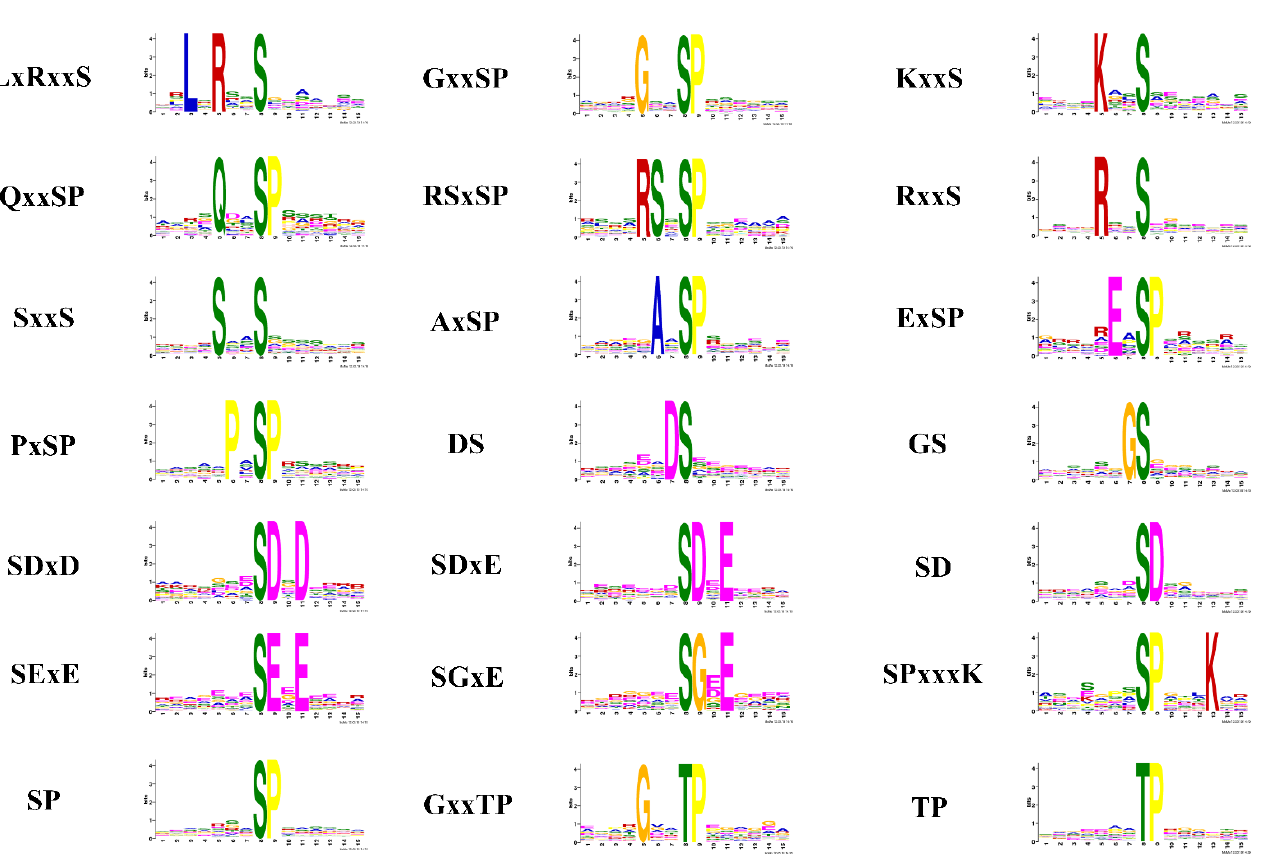
Figure 5. Phosphorylation site motif analysis of the upregulated DEPs using Motif-X. The degree of amino acids emerging at specific locations is represented by the elevation of the symbols.